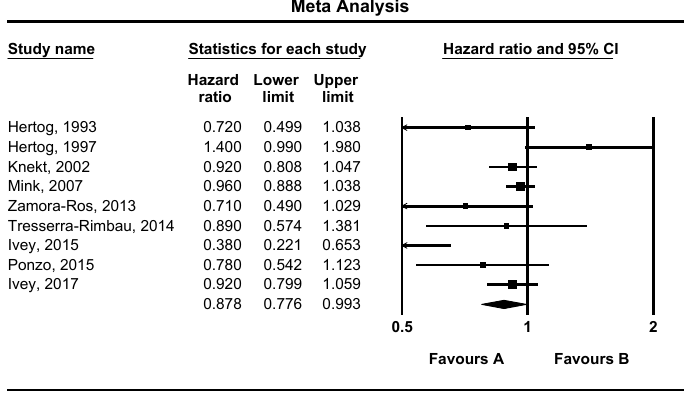
Figure 2. Forest plot of flavonoid intake and risk of total mortality.